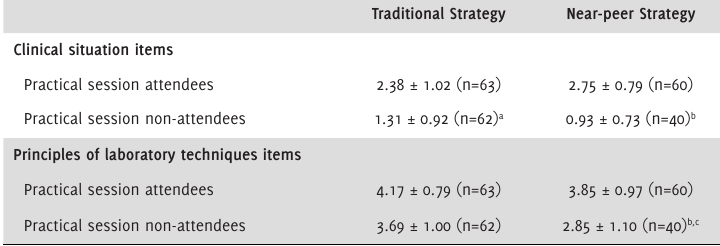
Table 1. Evaluation of Learning at Histology Laboratory